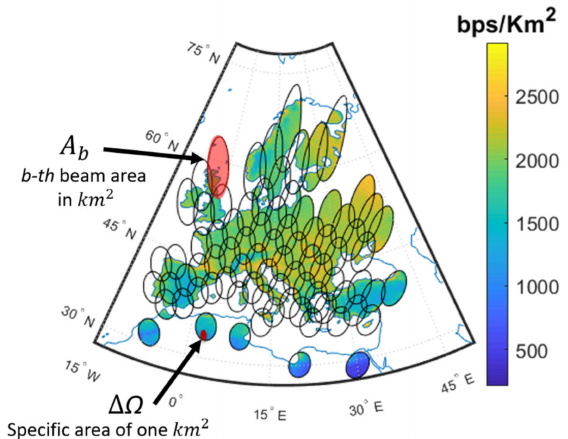
Figure 2. Required traffic distribution in the service area. The traffic demand will depend on the beam area and the average required capacity per km 2